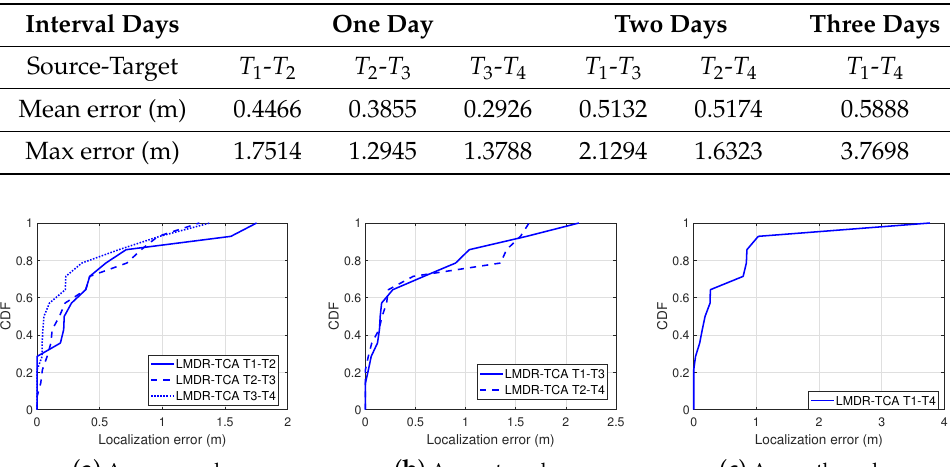
Table 3. Localization errors across different days.